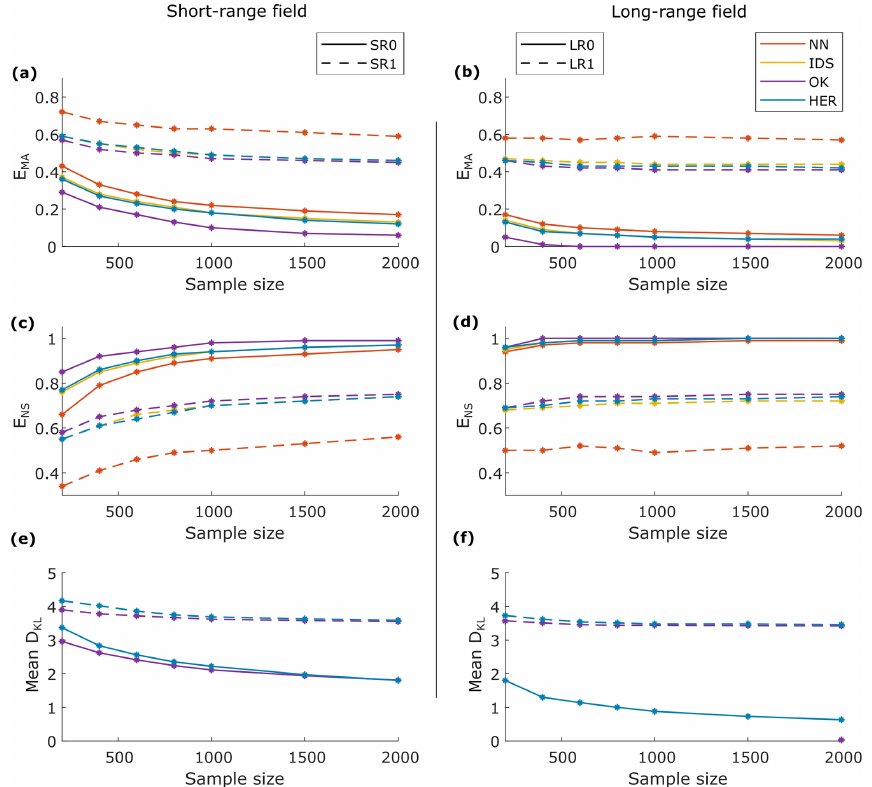
Figure 8. Performance comparison of NN, IDS, OK, and HER. (a, b) Mean absolute error, (c, d) Nash–Sutcliffe efficiency, and (e, f) Kullback–Leibler divergence scoring rule for the SR data sets in the left panels (a, c, and e) and the LR data sets in the right panels (b, d, and f) . Continuous line refers to data sets without noise and dashed lines to data sets with